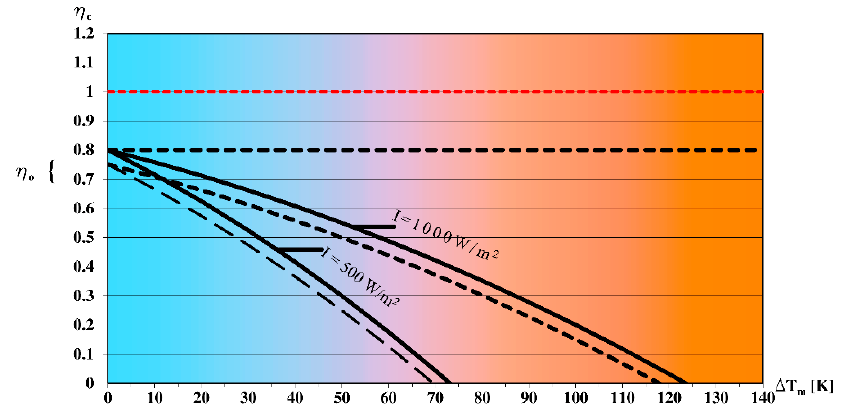
Figure 6. Yield curves of the flat-plane collector, depending on the operation temperature regime within the case study.